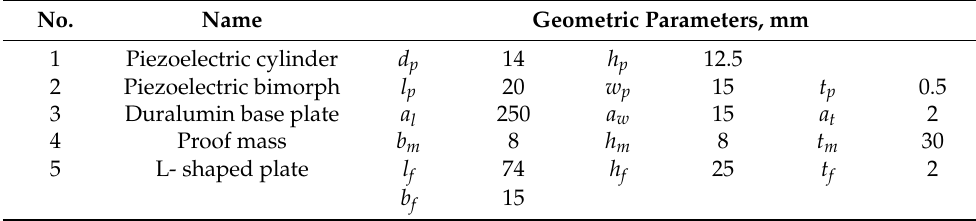
Table 2. Mechanical properties of materials.